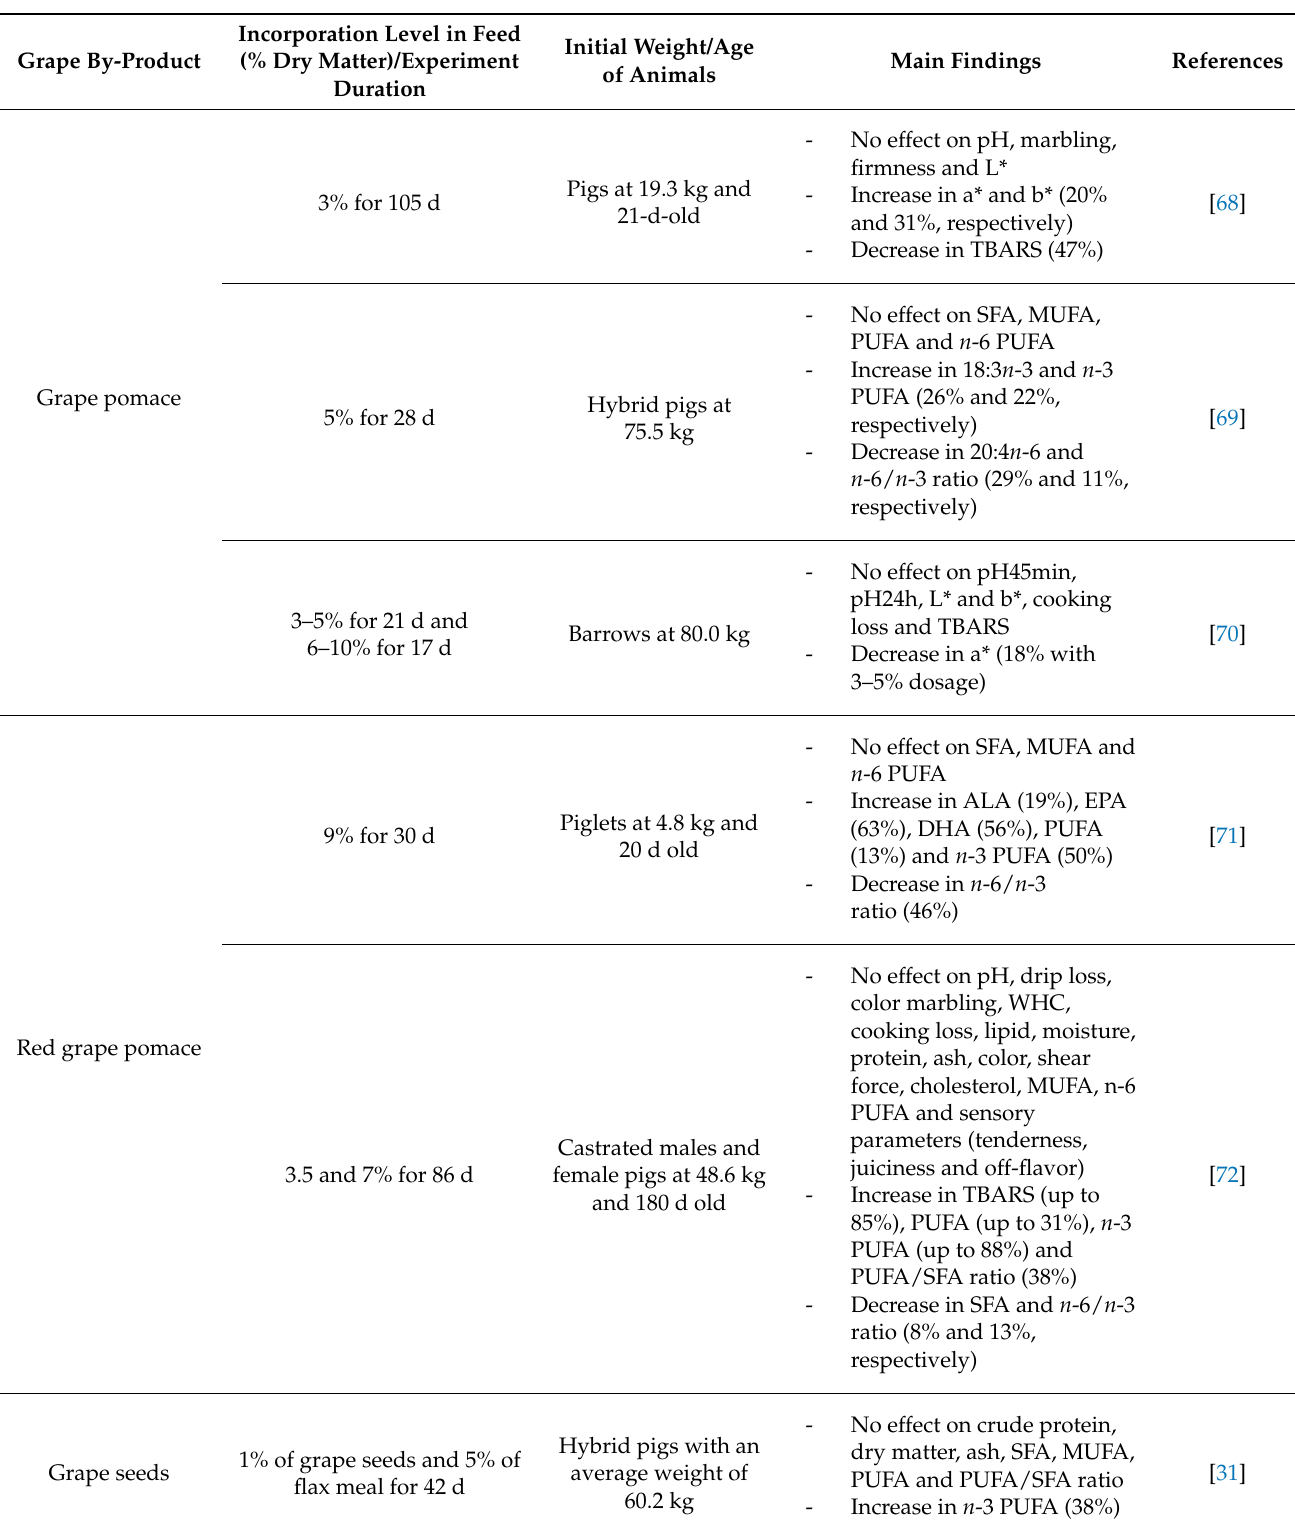
Table 2. Main effects of dietary inclusion of grape by-products on pork quality